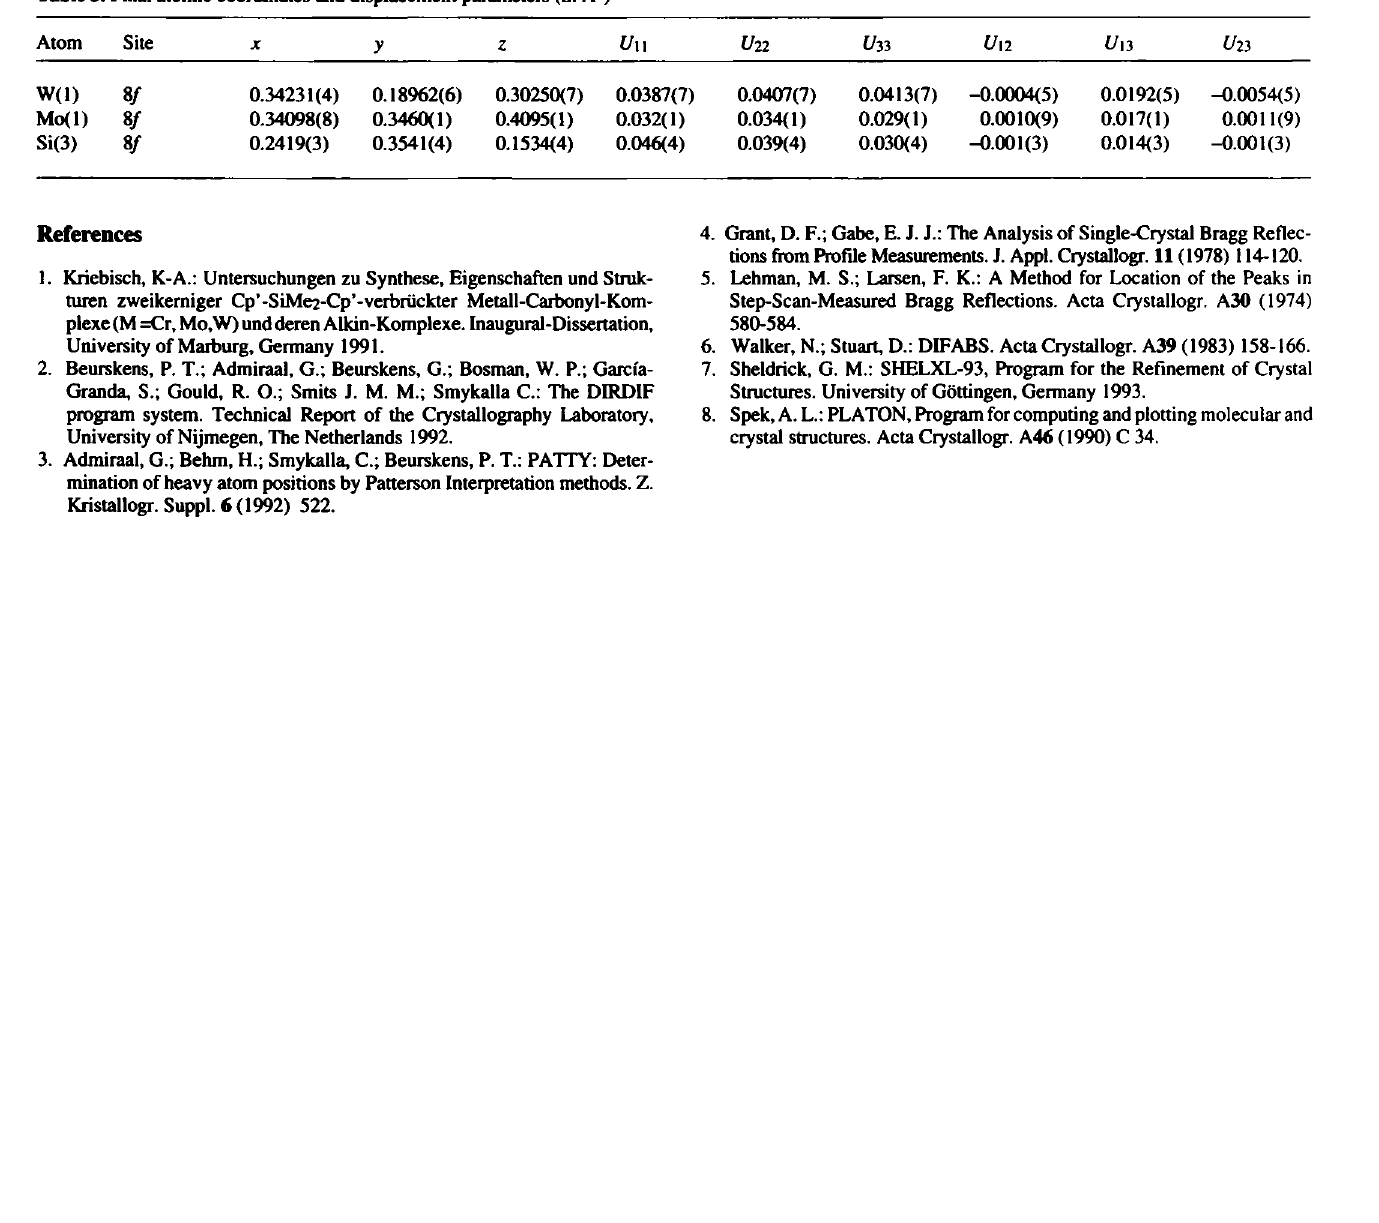
Table 3. Final atomic coordinates and displacement parameters (in Â 2